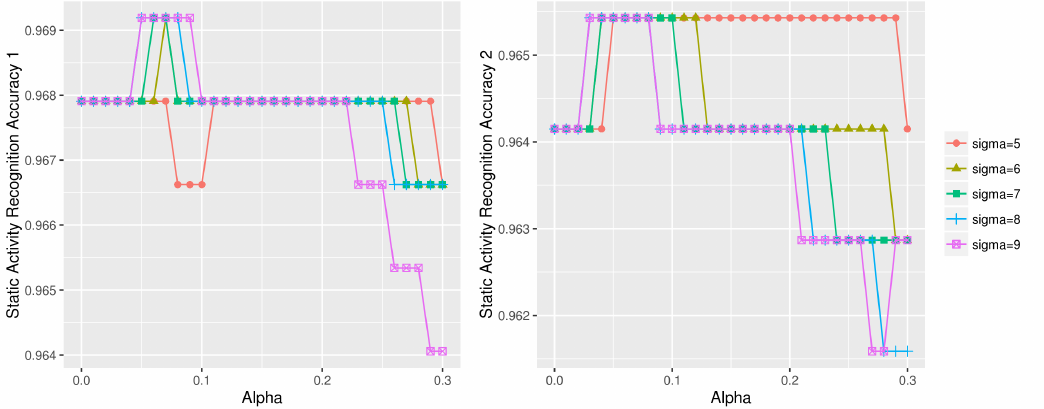
Figure 18. Static activity recognition accuracy using various ( σ , α ) combinations on UCI HAR dataset (left: static test data1, right: static test